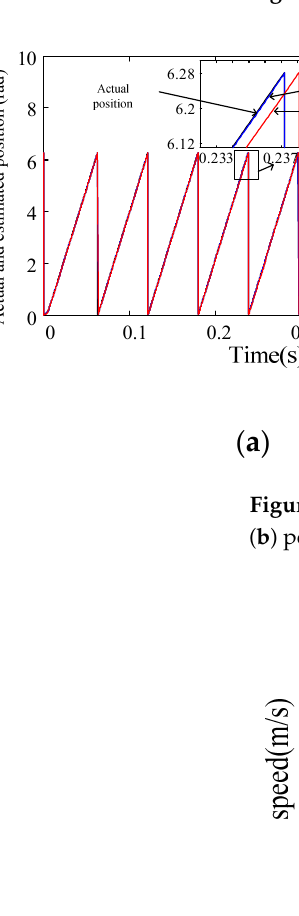
Figure 7. The back - EMF estimation. ( a ) The respective; ( b ) the compound. Figure 7. The back-EMF estimation. ( a ) The respective; ( b ) the compound.